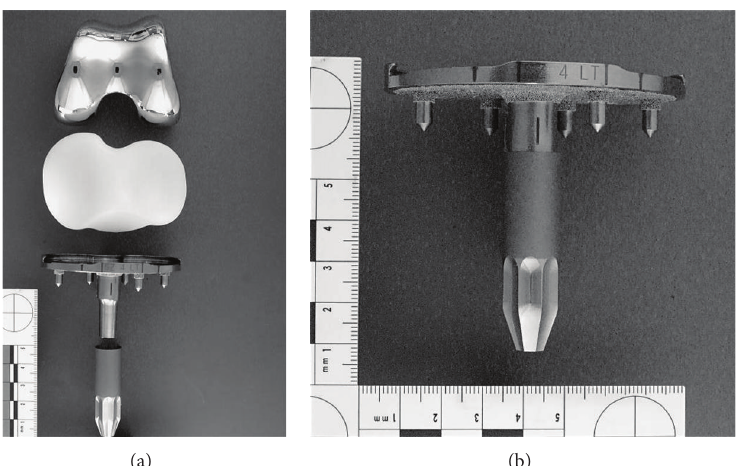
Figure 1: Gross photographs of disassembled individual components of the Profix TKA (a) and an assembled tibial component with stem (b) used in the current